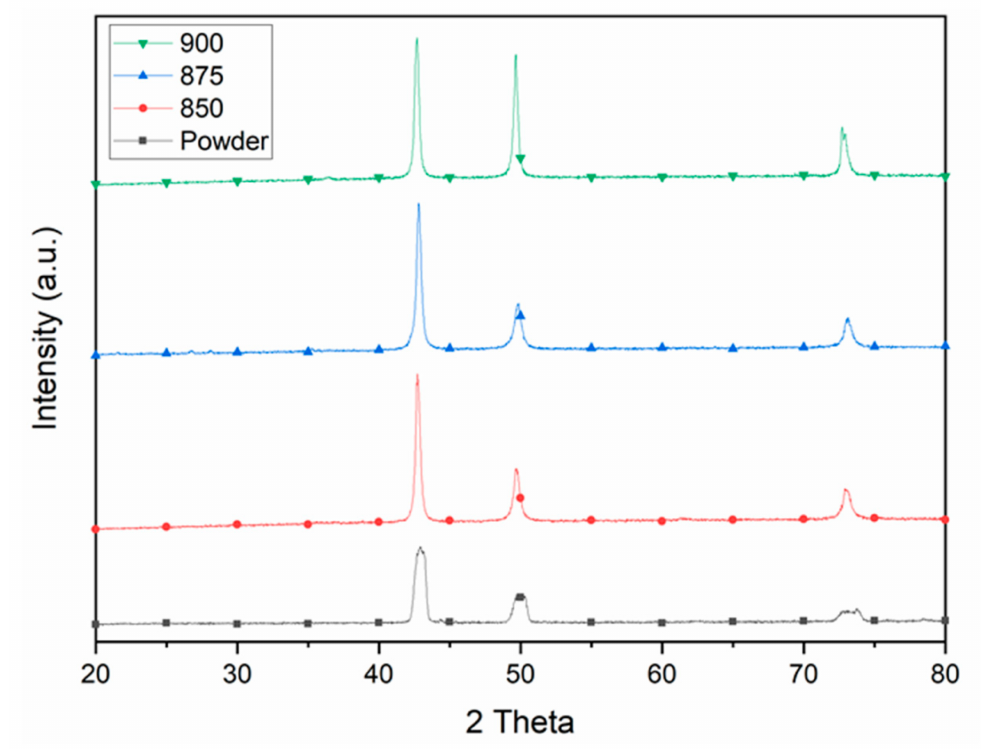
Figure 8. XRD results of sintered bronze samples and powder (as